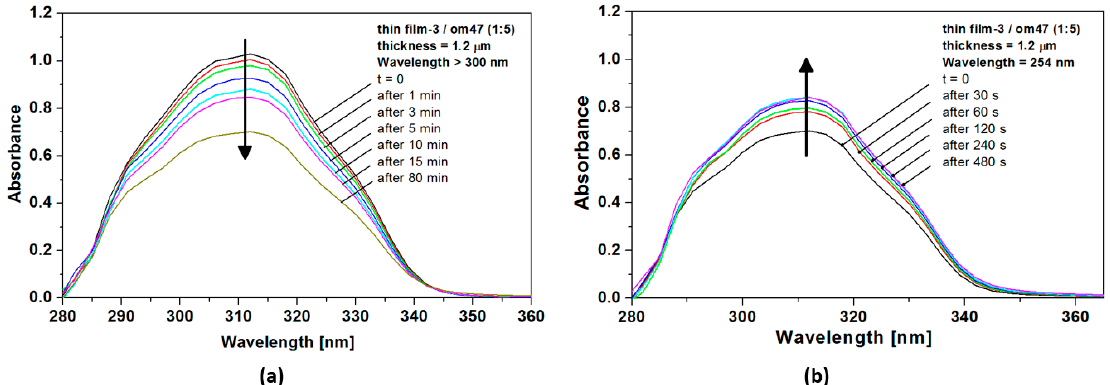
Figure 1. ( a ) Evolution of the absorption spectrum of a P17 thin film (1.2 μ m) with time upon irradiation at λ > 300 nm; ( b ) Changes of the absorption spectrum of cross-linked P17 thin film upon irradiation at 254 nm.